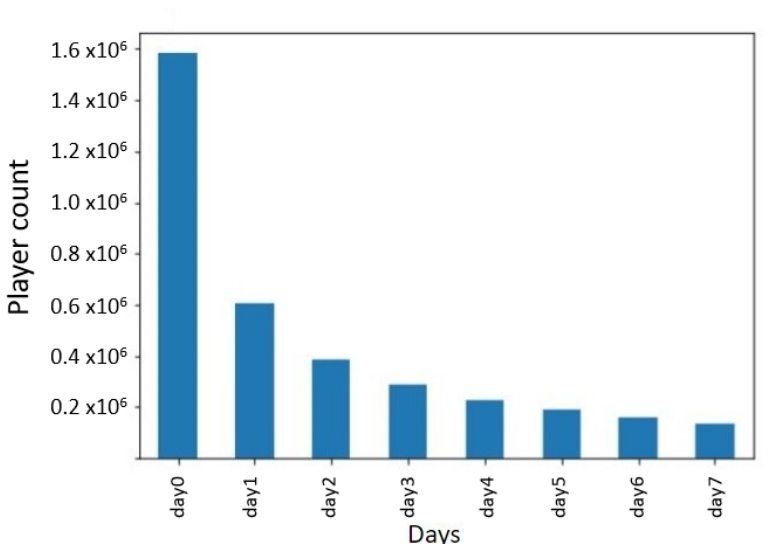
Figure 4. Number of players active in the game on a certain day after having installed the game.